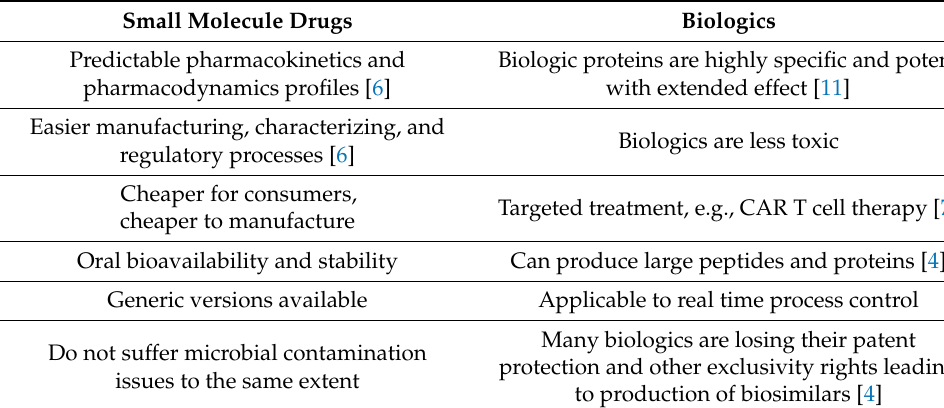
Table 1. Outlining the advantages of traditional chemical synthesis of small molecules and the advantages of